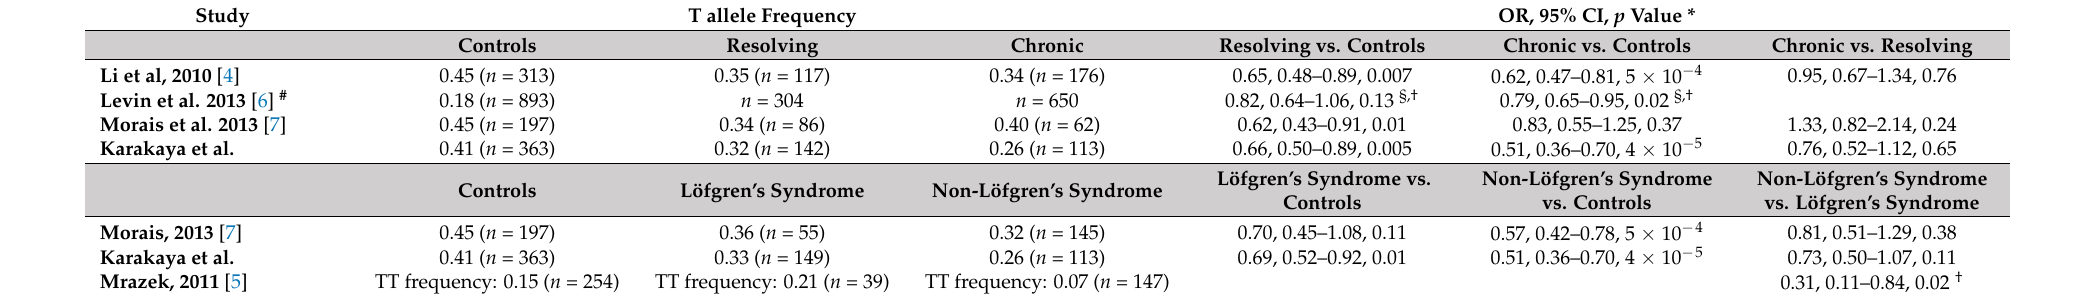
Table 5. Studies reporting an association of ANXA11 rs1049550 with sarcoidosis disease